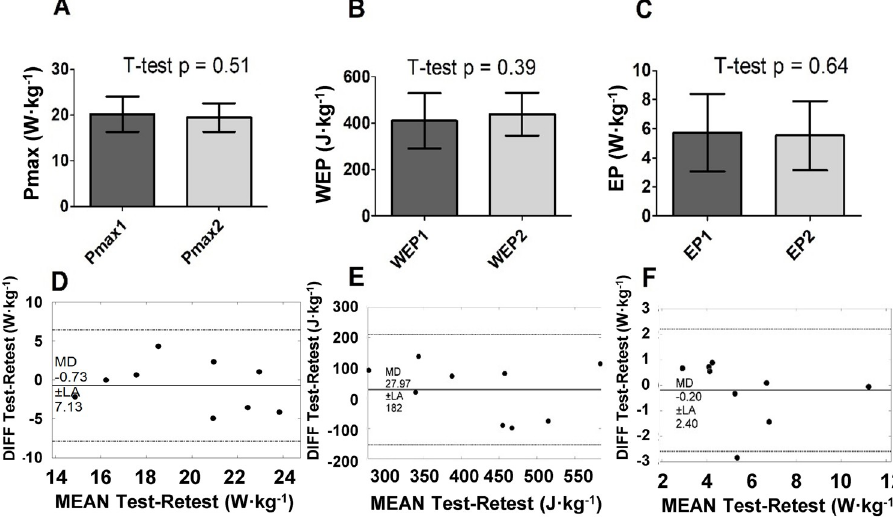
Fig 3. Test-retest comparison of AO3 parameters in mean and SD (Pmax–A; WEP–C; EP–E) and by Bland Altman analysis (Pmax–D; WEP–E; EP–F); (n = 9). Pmax—maximum power; EP–end power; WEP–area above end